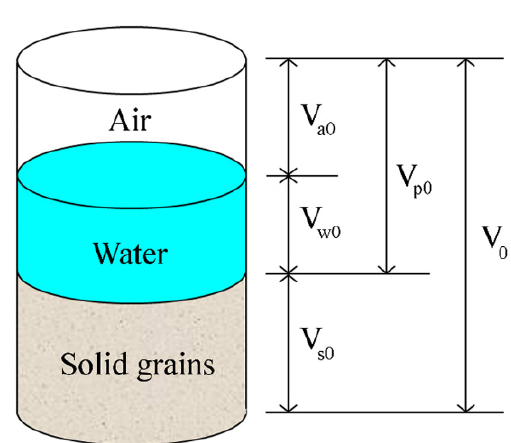
where i = a,w,s represents air, water and solid grains, respectively. The initial saturation, S , is determined as